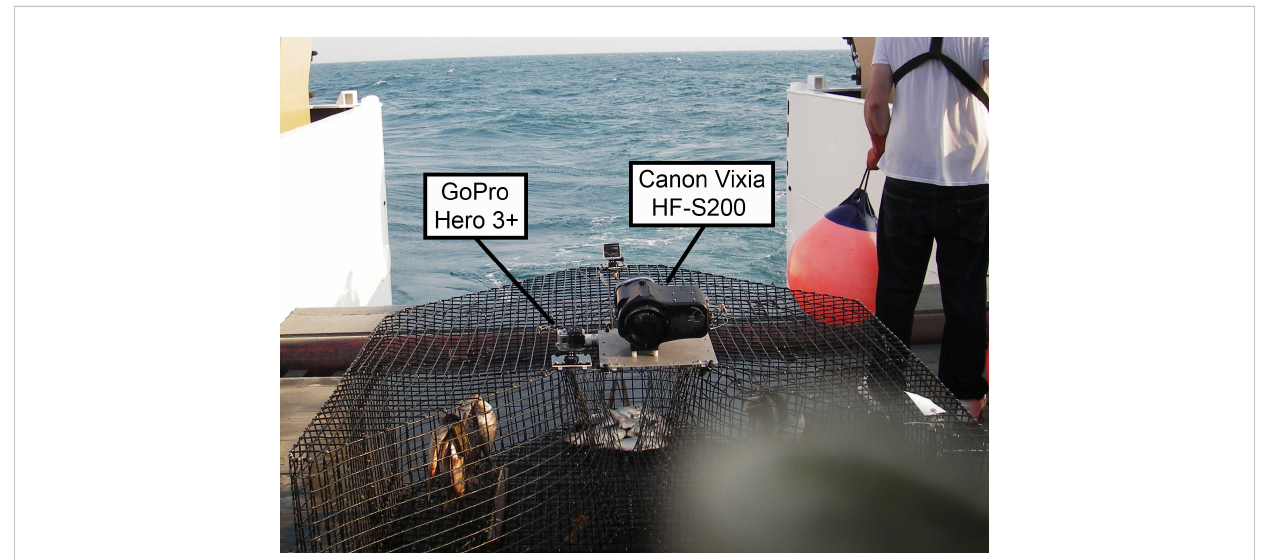
FIGURE 1 Side-by-side calibration experiment conducted by the Southeast Reef Fish Survey along the southeast United States Atlantic coast in 2014. Canon Vixia HF-S200 and GoPro Hero 3+ cameras were attached to baited traps side-by-side looking outward and read for fi sh at exactly the same times using the MeanCount approach (Schobernd et al.,